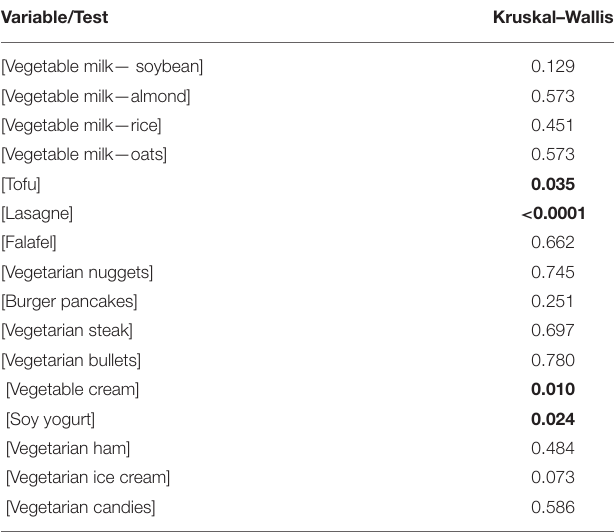
Frontiers in Sustainable Food Systems |